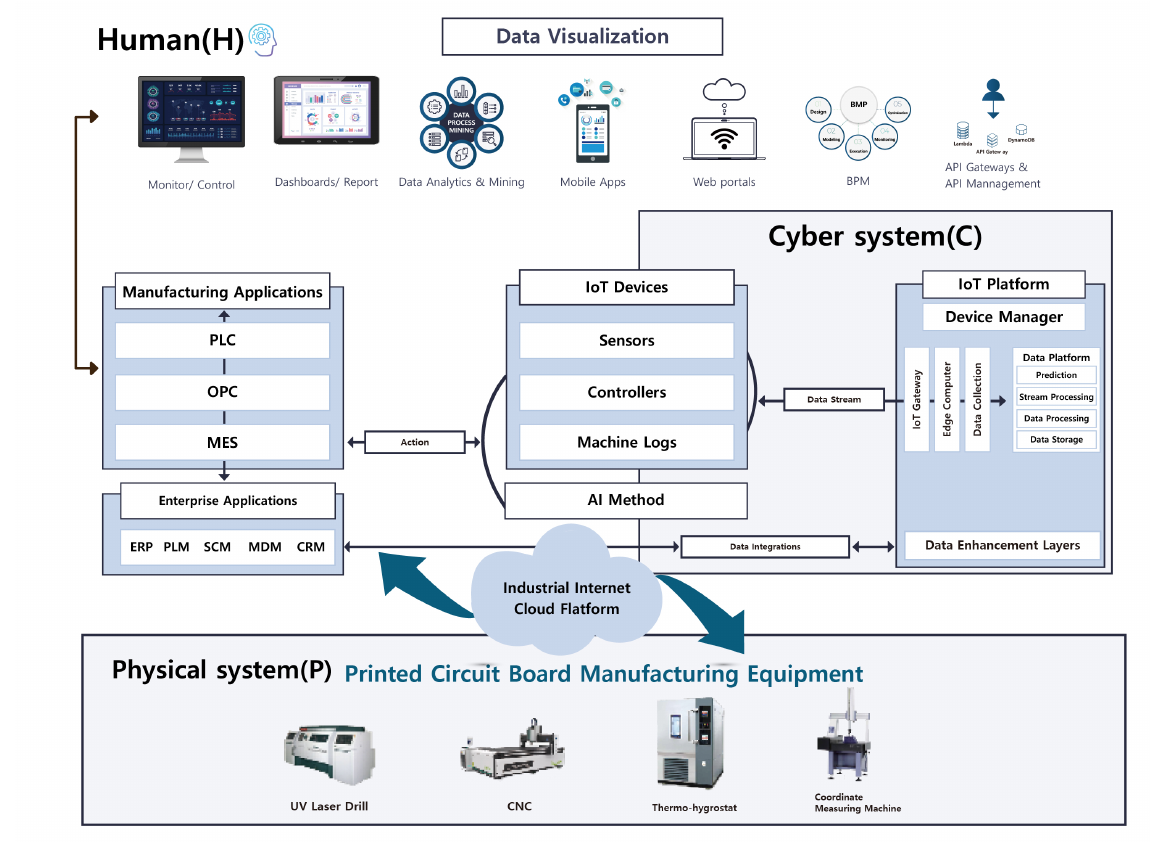
Figure 4. The architecture of our HCPS-based PCB smart factory